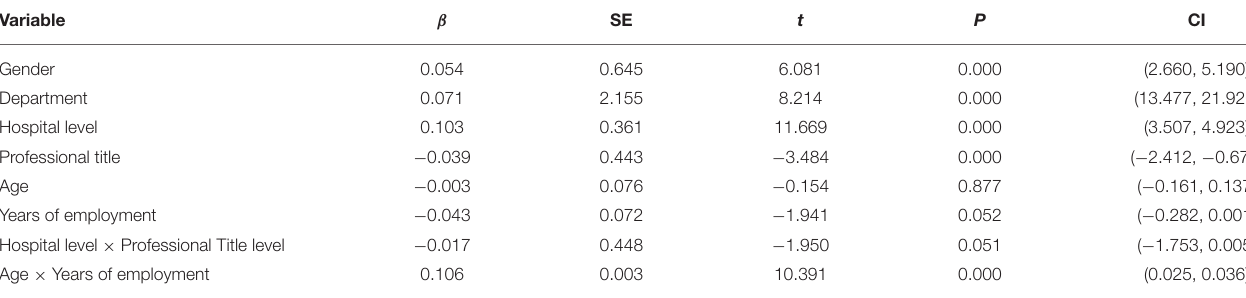
TABLE 3 | Linear regression analysis of the probability of medical staff actively paying attention to the psycho-social state of patients. Variable